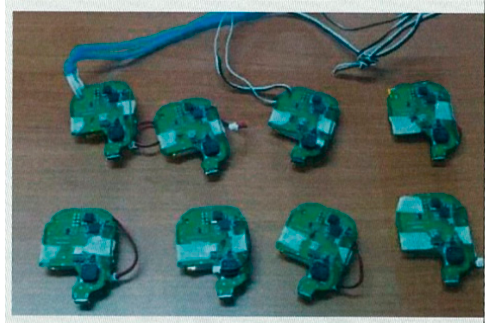
Figure 14. Hardware of Bluetooth low-energy (BLE) transmitter.